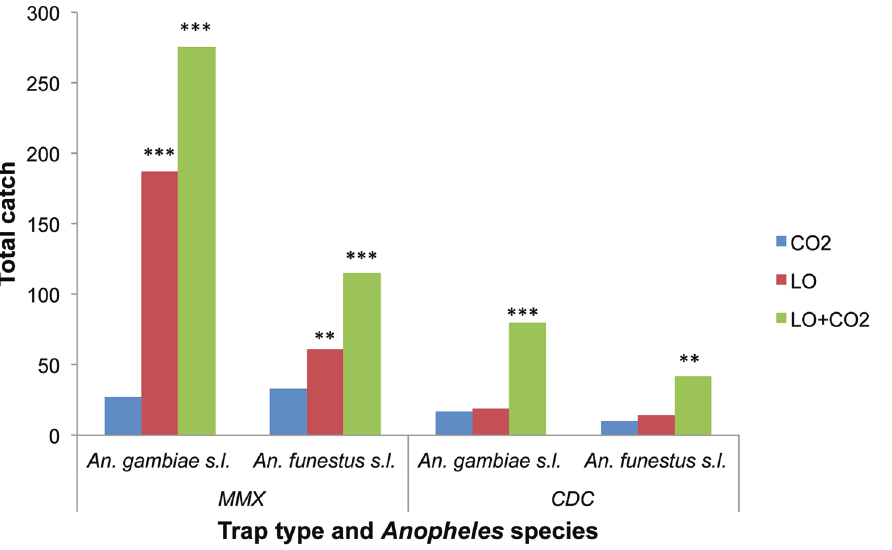
Figure 1. Trapping efficacies of carbon dioxide and linalool oxide for An.gambiaes.l. and An.funestuss.l. . Number of replicates =18; bars capped with asterisks are significantly different from their respective controls as determined by general linear model with negative-binomial error structure and log link in R 2.15.1 software; ** = P , 0.01, *** = P , 0.001.